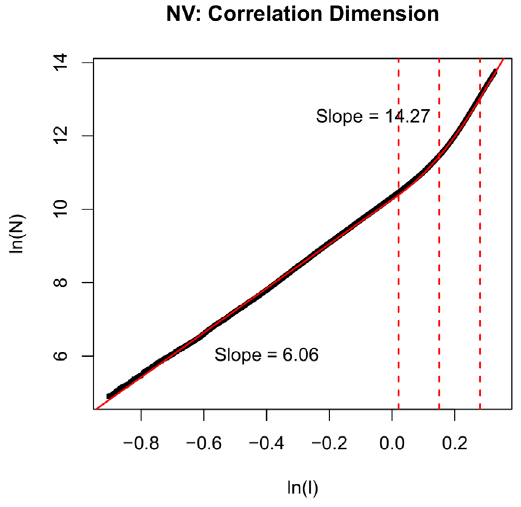
Figure 2. The correlation dimension plot for NV’s images shows a two-scaled geometry. The bent-cable regression lower scale correlation dimension estimate is 6.06 and the top scale correlation dimension estimate is